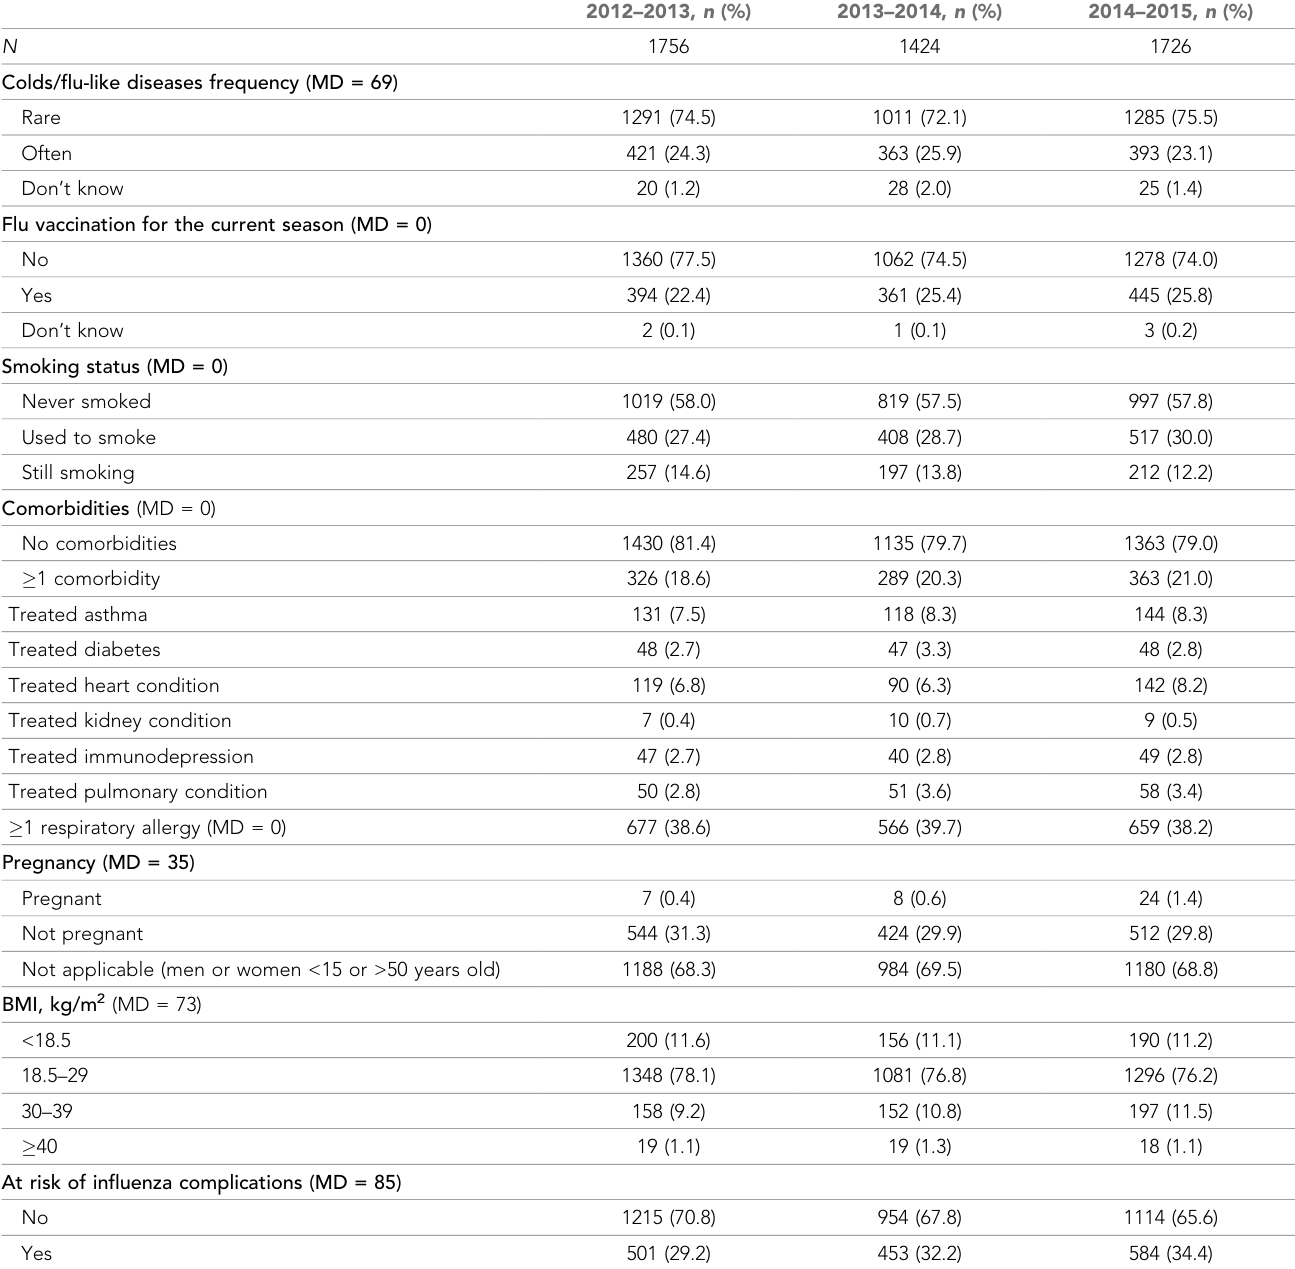
Table 2. Health characteristics of individuals included in the study (an individual may have been involved in 1, 2, or 3